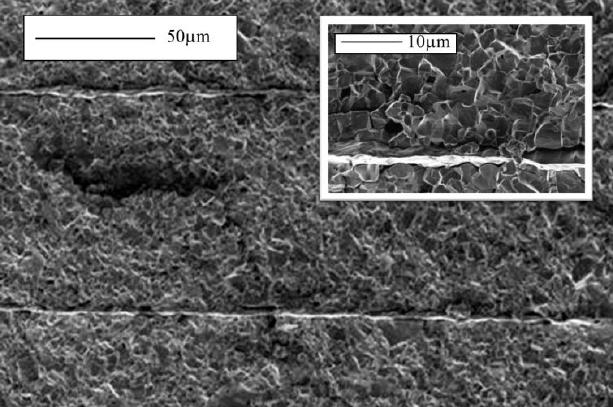
Figure 5. SEM image of multilayer sample with 3 wt% excess PbO [38].